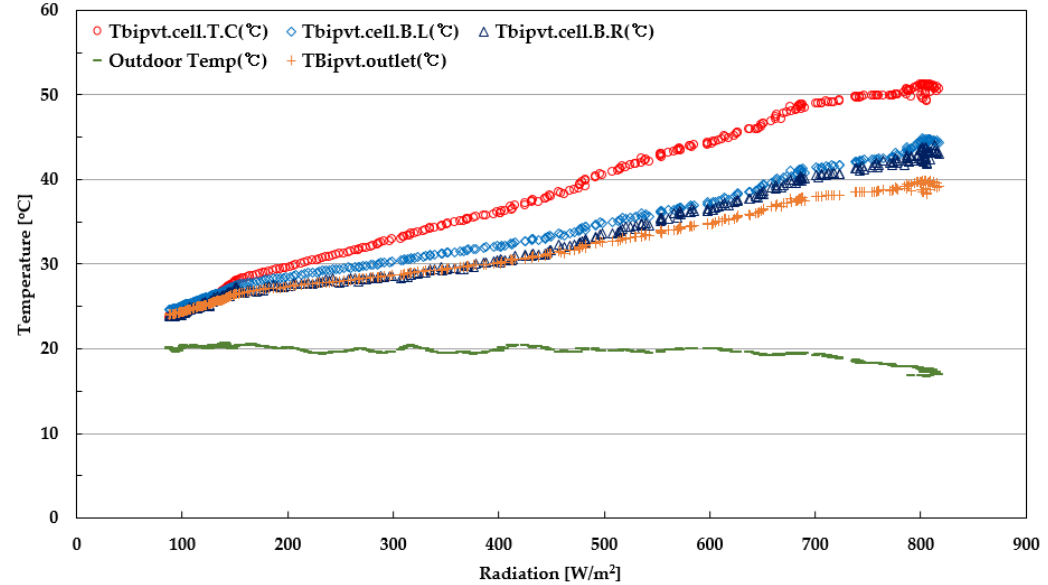
Figure 14. Daily ambient condition of an air-type BIPVT